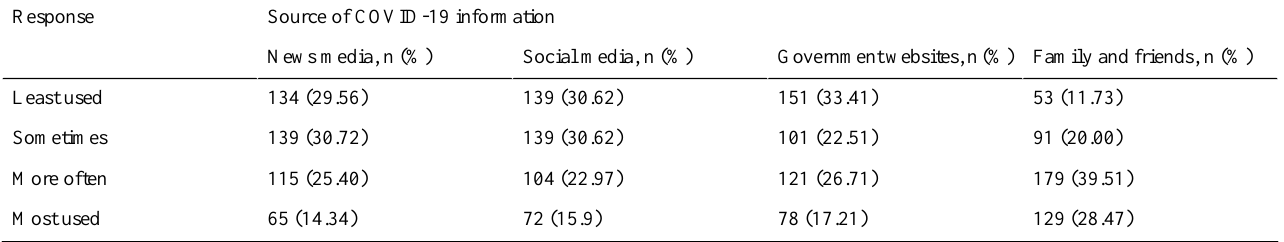
Table 2. Participants’sources for reliable information about coronavirus disease 2019 (COVID-19)